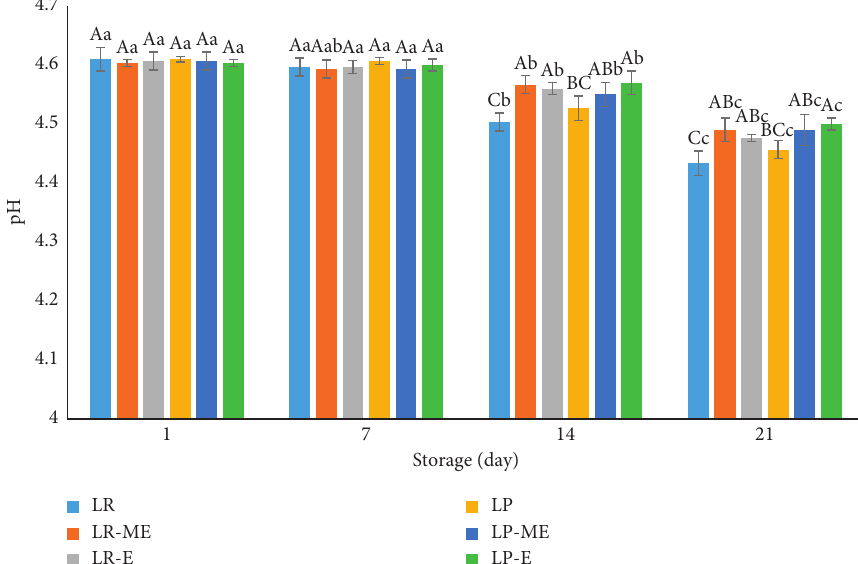
Figure 2: pH content of probiotic yogurt. LR ( L. rhamnosus ), LR-ME (encapsulated L. rhamnosus in multilayer emulsion), LR-E (en- capsulated L. rhamnosus in emulsion), LP ( L. plantarum ), LP-ME (encapsulated L. plantarum in multilayer emulsion), and LP-E (en- capsulated L. plantarum in emulsion). Capital letters indicate significant differences between samples at the same storage time and different time; lowercase letters indicate significant differences between the same samples at different storage times.